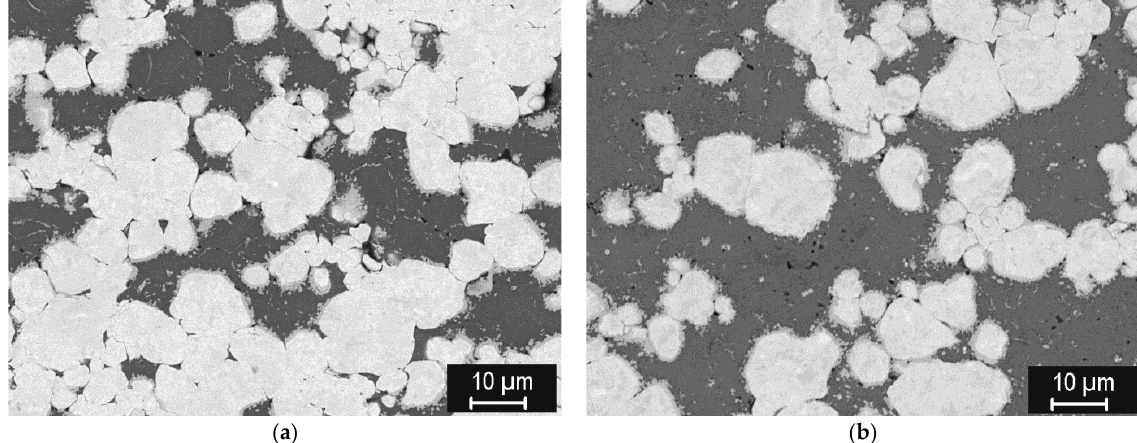
Figure 8. Influence of sintering temperature on the thermal diffusivity of steel compacts (at 100 °C).